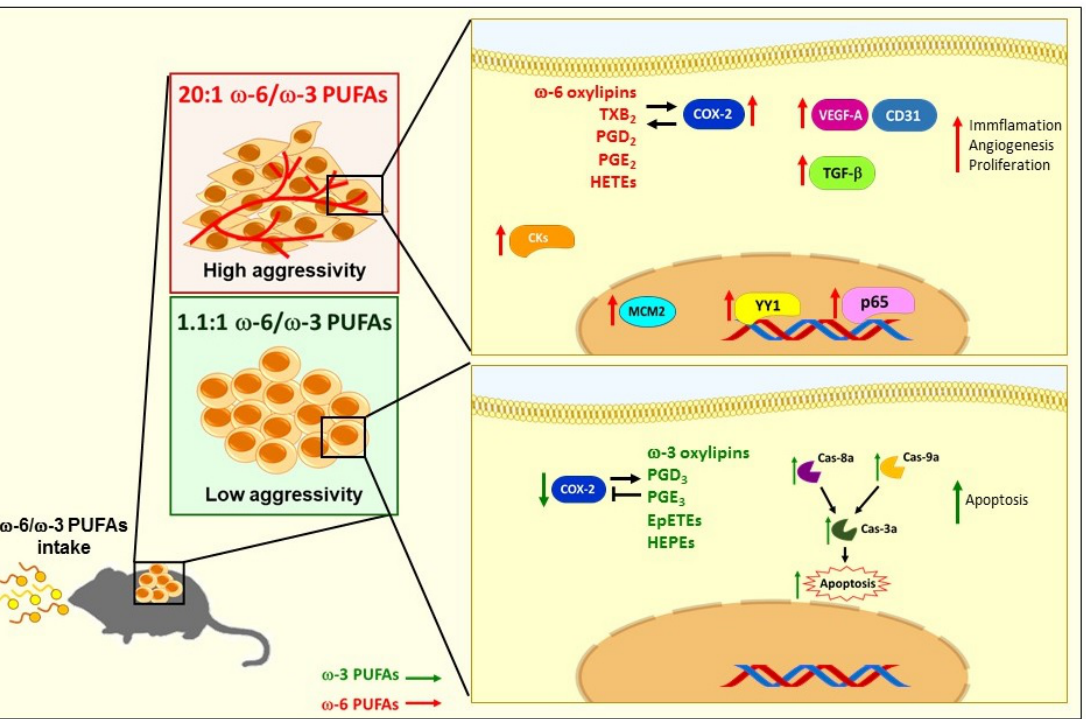
Figure 7. Model of the effect of ω -6 and ω -3 PUFAs on tumor aggressiveness in a murine model of lung cancer. Our study proposes that high intake of ω -6 in the diet increases the aggressiveness of tumor cells compared to animals fed a balanced diet or control diet. This was reflected in histological changes, in tumor dedifferentiation and increased cell proliferation and angiogenesis. It additionally increases the nuclear expression of NF κ B p65 that correlates with an increase in the expression and activation of YY1 that promotes the transcription of COX-2 and TGF- β . On the other hand, a balanced diet induces apoptosis dependent on caspase-3, -8 and -9, which could partly explain why this group of mice shows moderate aggressiveness.